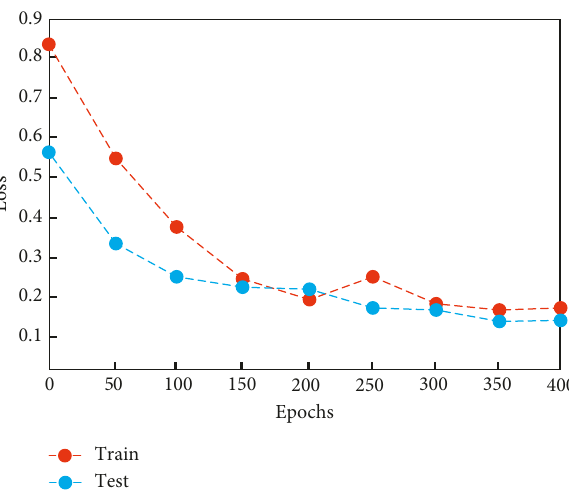
Figure 6: Experimental results of residual network loss function.